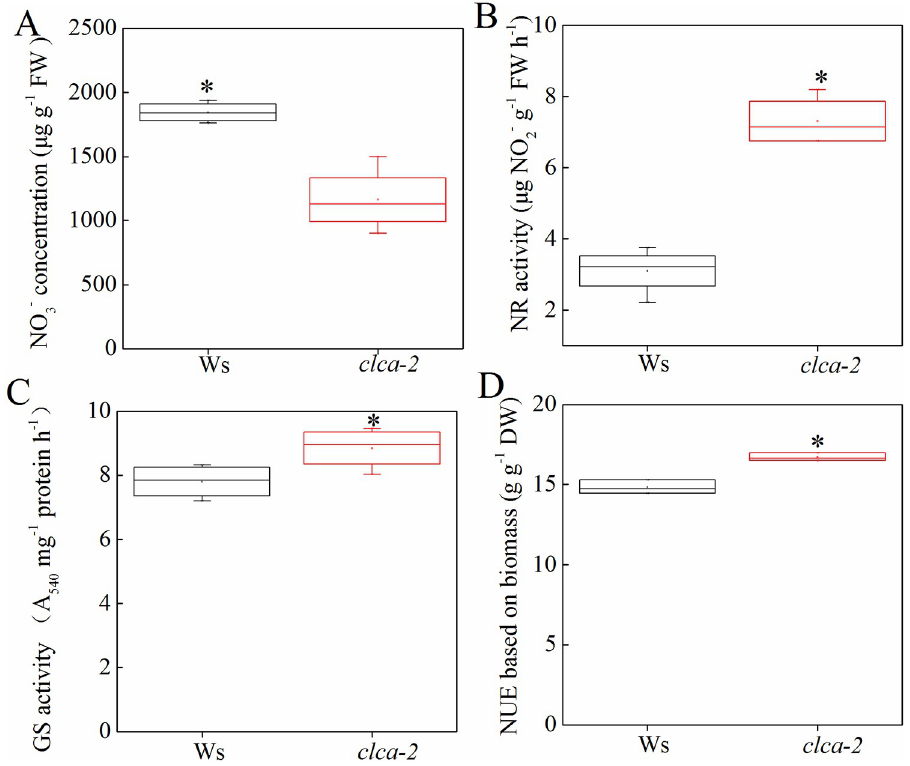
Fig 1. Decreased NO 3- concentration in the clca-2 mutant accelerated nitrogen (N) assimilation, resulting in higher N use efficiency (NUE). Plants grown hydroponically were sampled for further analysis at the seedling stage. Conditions for hydroponics culture and characteristics of Arabidopsis thalina (A . thaliana) are defined in the “Methods”. The wild-type Wassilewskija (Ws) plants were used as the control for the CLC null mutant ( clca-2 ). At the seedling stage, plants were sampled for NO 3- assays (A), and the activities of nitrate reductase (NR) (B) and glutamine synthetase (GS) (C) were shown in Ws and clca-2 . NUE values were calculated based on total biomass (shoot and root) per total N uptake, and the differences in NUE of Ws and clca-2 were shown in D. Bars indicate standard deviations (SD) of four biological replicates. The asterisks denote significant differences at P <